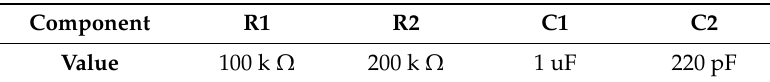
Table 2. The compensator